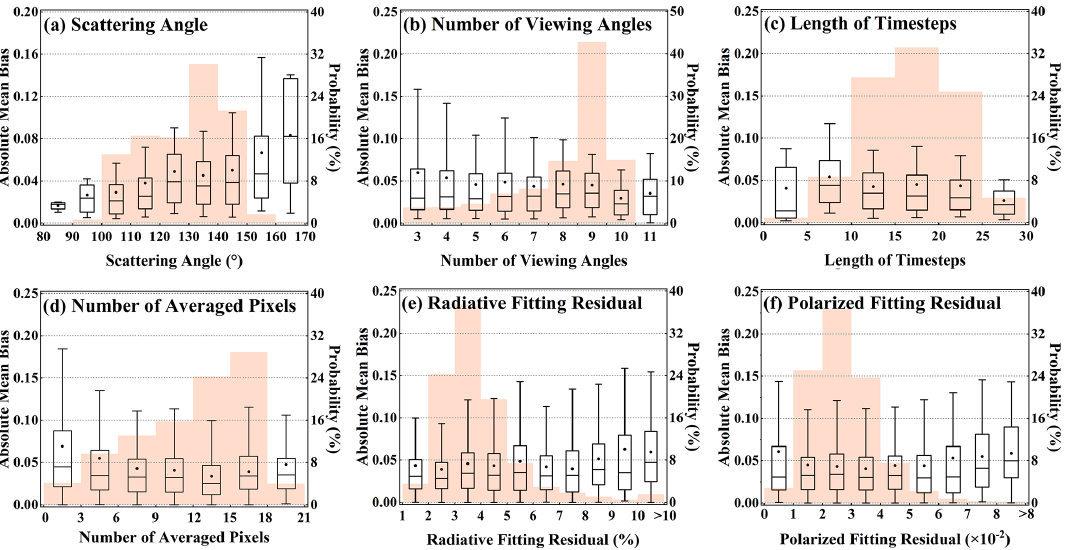
Figure 3. Influencing factors of AOD retrieval performance of DPC based on the GRASP/Model scheme: (a) SCA, (b) number of viewing angles, (c) length of time steps, (d) number of averaged pixels, (e) non-polarized fitting residual, and (f) polarized fitting residual. Orange shadows in the background represent the probability distribution of the